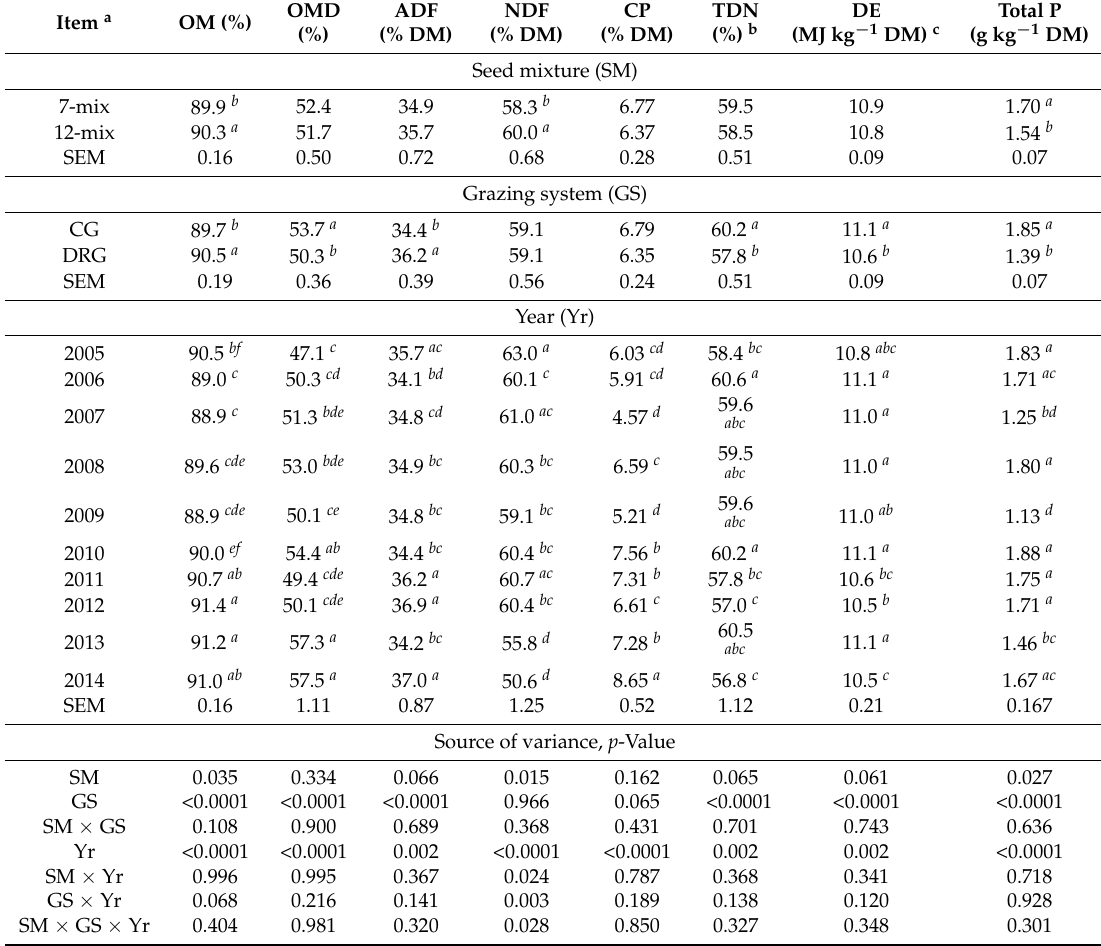
Table 4. The effect of seed mixture (7-mix, 12-mix), grazing system (continuous grazing (CG), deferred rotational grazing (DRG)) and production year (Yr) on pasture